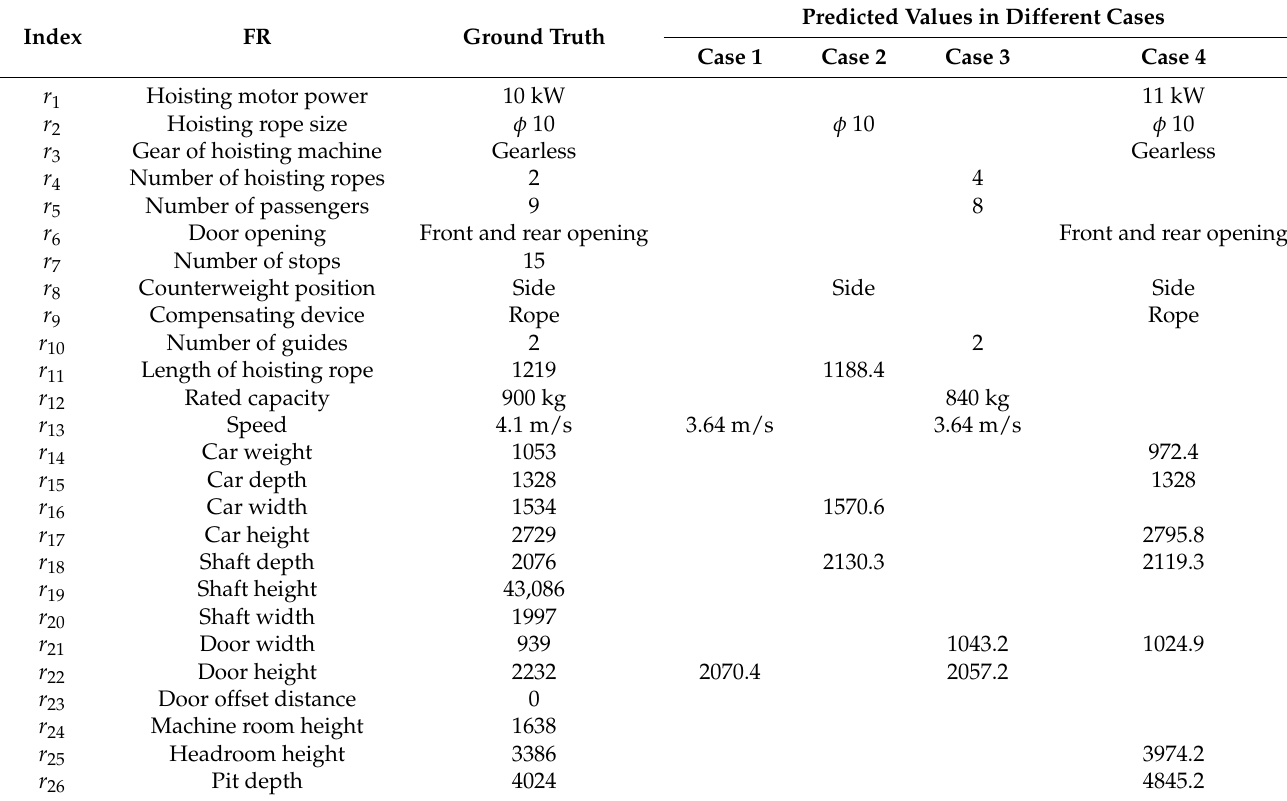
Table 4. Predicted values of a new FR in